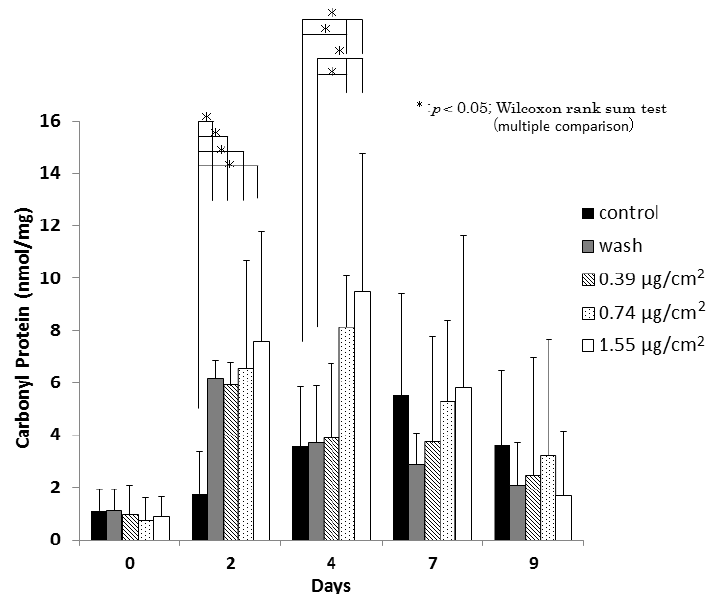
Figure 7. Effect of Ag NPs/CNFS or CNFS treatment on carbonyl protein generation. Carbonyl protein levels in the washes of various concentrations of Ag NPs/CNFS, CNFS, and washed groups were measured, as illustrated in Figure 6. The wash group was treated with 1.55 μg/cm 2 Ag NPs/CNFS for 2 days and then treated with 1.55 μg/cm 2 Ag NPs/CNFS after washing the wound with saline on days 2 and 4. Data represent the mean ± SD of 6 determinations, Wilcoxon’s rank sum test (multiple comparison), * p < 0.05.